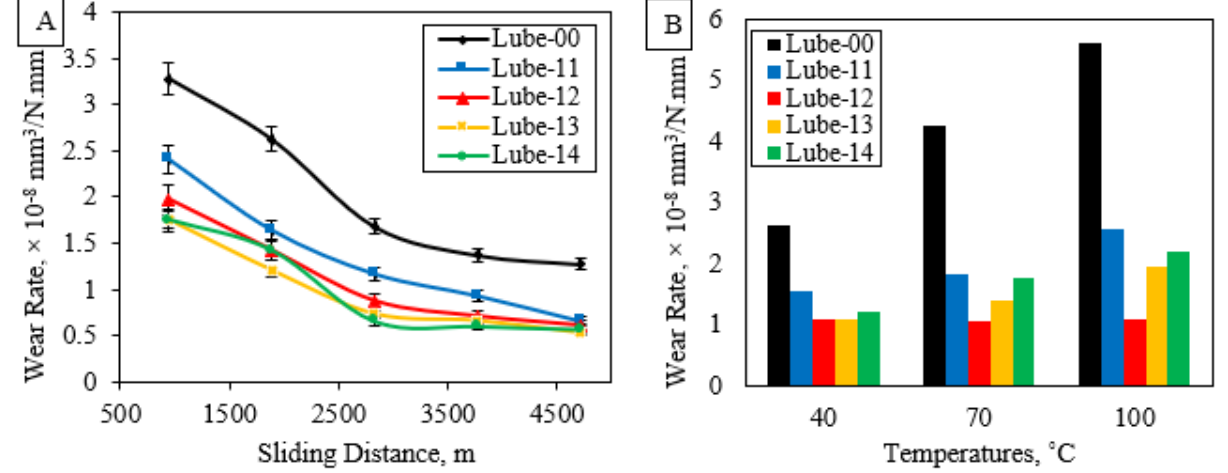
Figure 5. Wear rate of hybrid nano lubricant samples with various loading contents of Al 2 O 3 NPs and 0.5 wt.% MWCNTs ( A ) at different speeds and ( B ) at different temperatures.